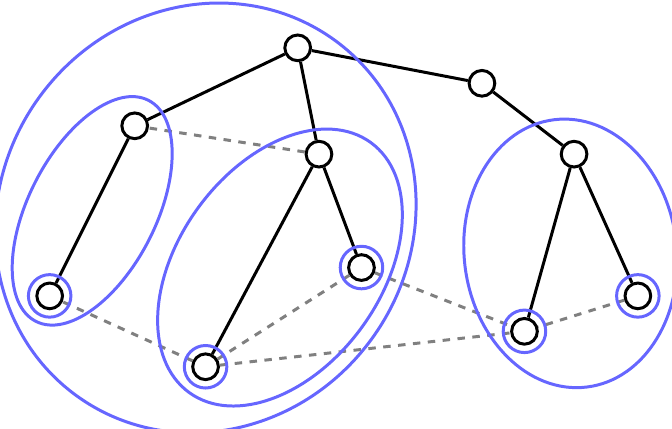
Figure 10. A cross-free family of connected subsets of the vertices, shown as blue circles, which contain the corresponding vertices. The cross-free family of subsets is associated to a unique (if existing) spanning tree (solid line). Observe that by construction, the family allows at least one choice of orientations of the edges (interpreted as energy flow) such that each cut has either only an incoming energy flow or only an outgoing energy